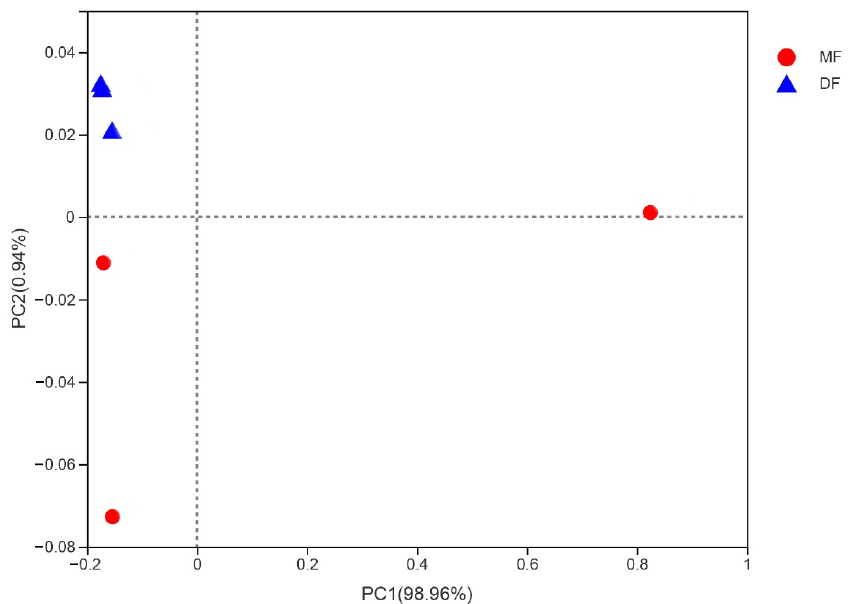
Figure 5. Principal coordinate analysis (PCoA) using the Bray–Curtis dissimilarity measurement comparing the alpha diversity of the bacterial community. MF, S. frugiperda fed on maize leaves; DF, S. frugiperda fed on artificial diet.